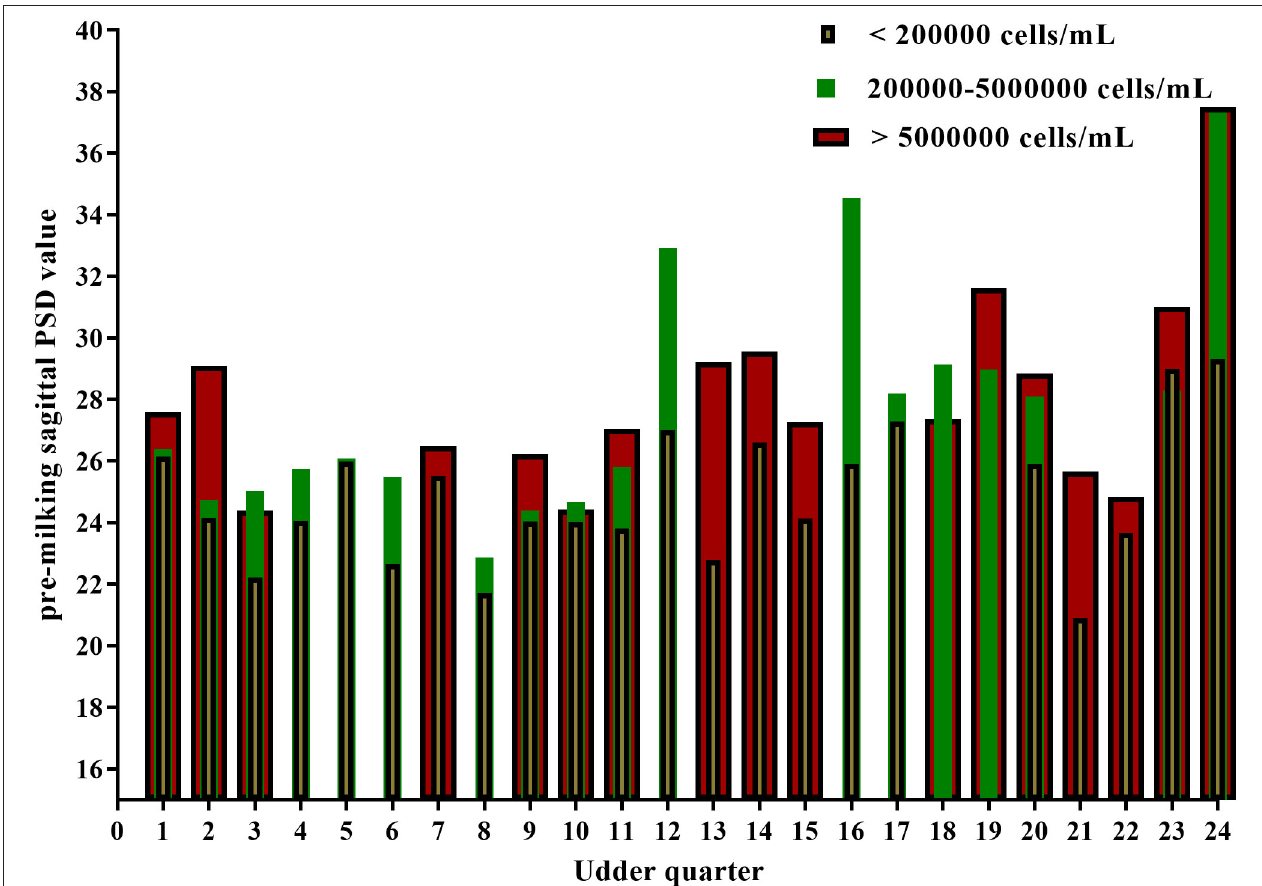
FIGURE 3 | Pre-milking sagittal PSD values of 24 quarter-level udders at different somatic cell